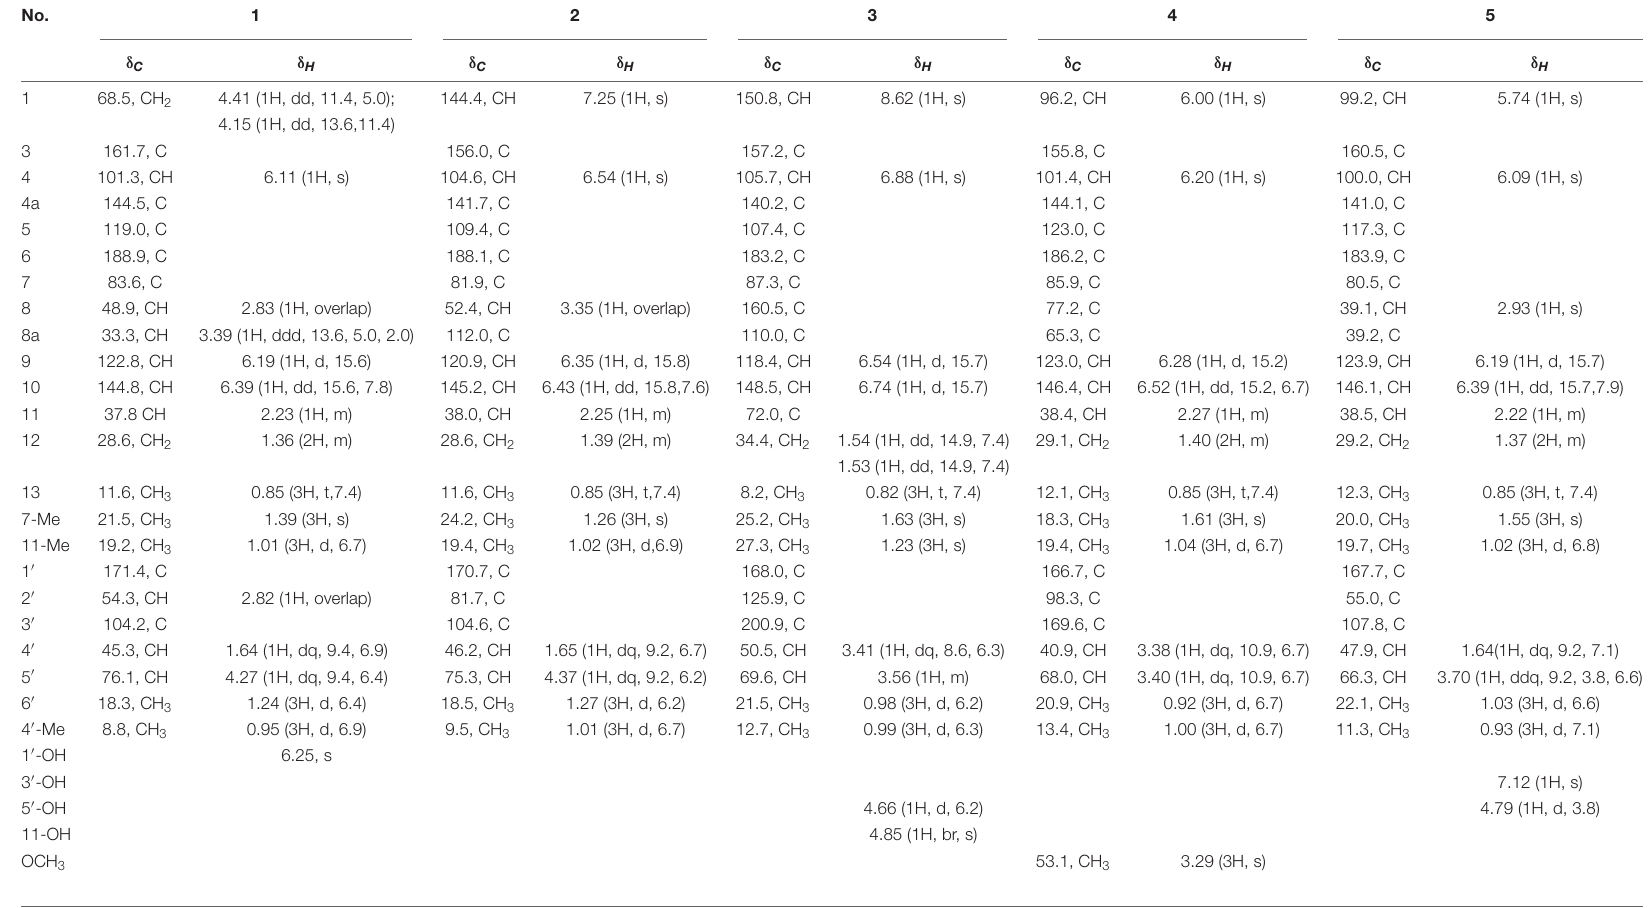
TABLE 1 | NMR data of compounds 1–5 in DMSO- d 6 (600 MHz for 1 H and 150 MHz for 13 C, δ in ppm, J in Hz).